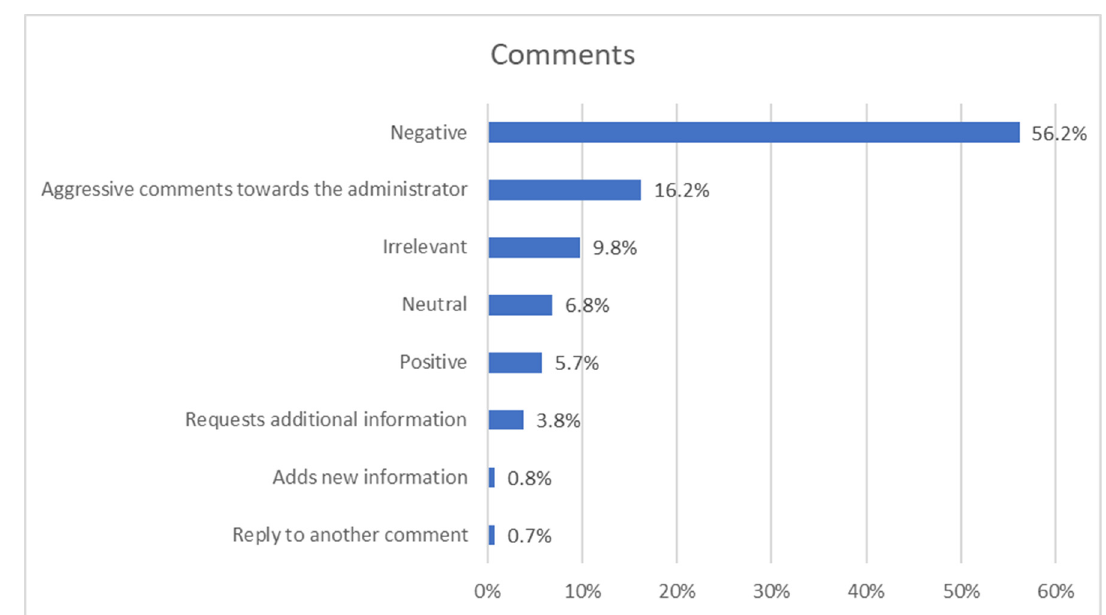
Figure 4. Categories of comments (%).